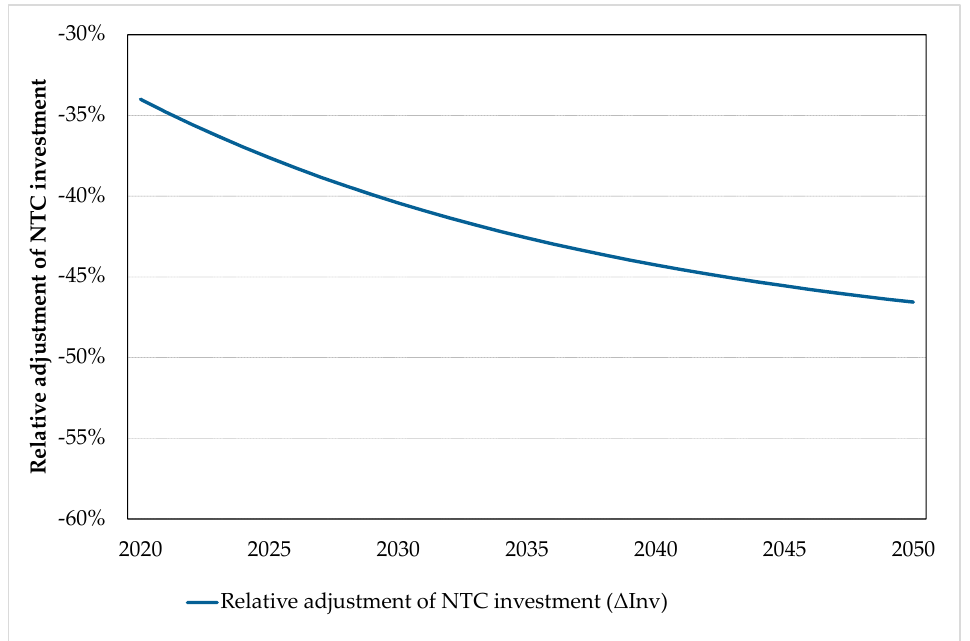
Figure 5. Development of relative NTC investment adjustment (own calculations and assumptions based on References [5,37]).